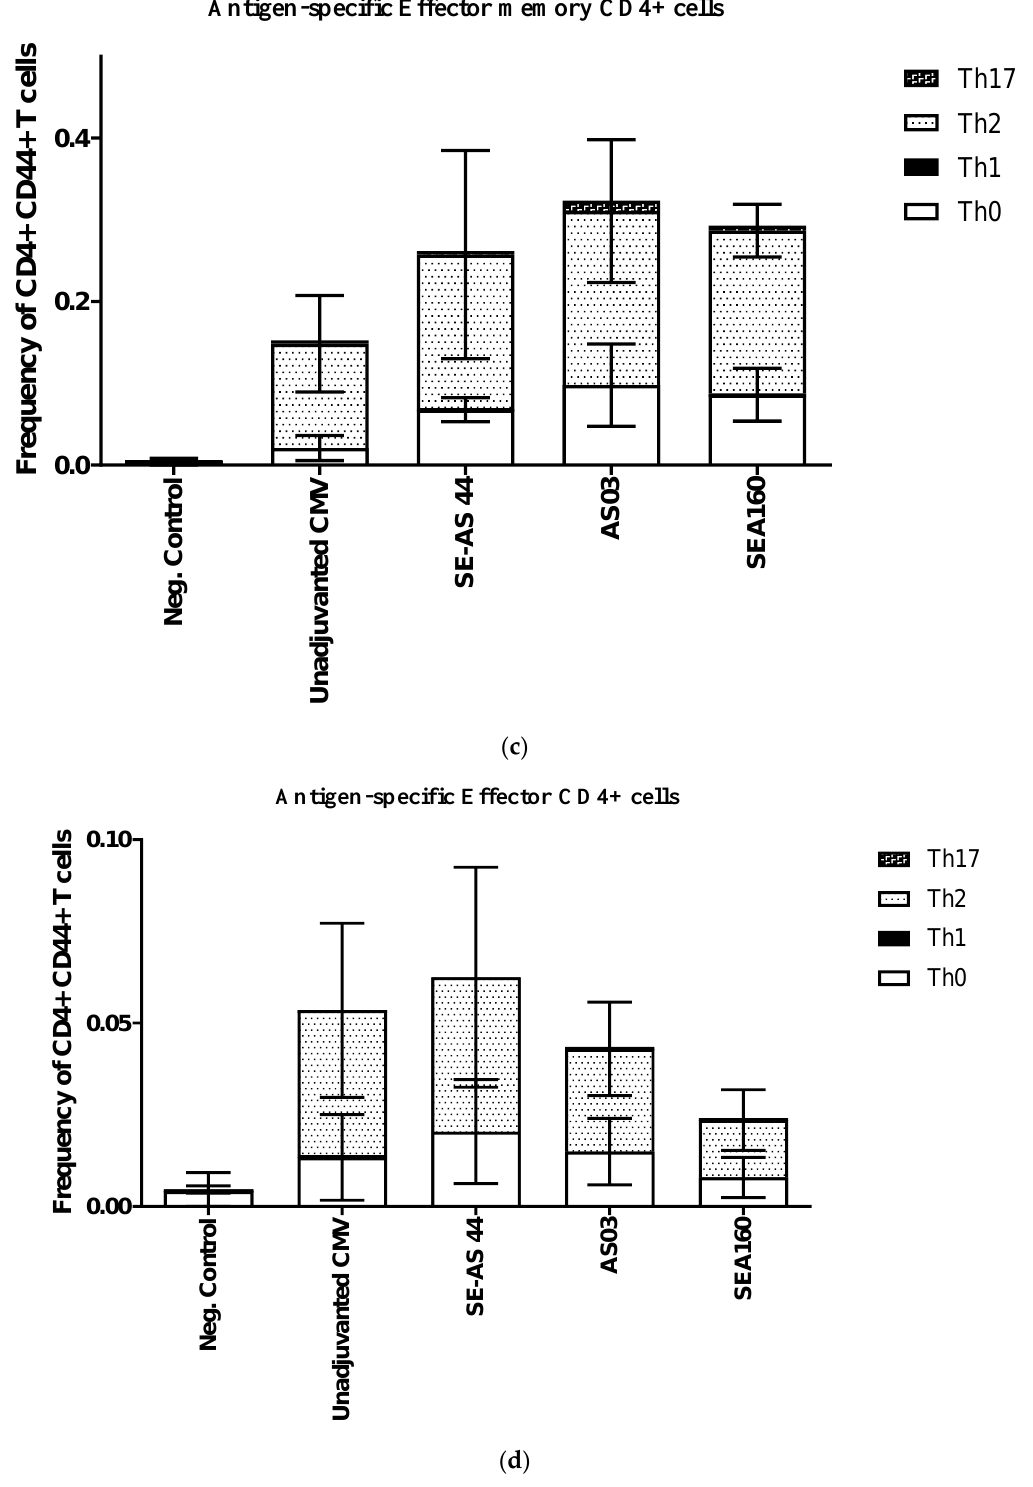
Figure 4. ( a ) Frequencies of overall antigen-specific CD4+ T cells classified as either central memory, effector memory or effector cells. Each bar represents stacked mean frequency data from n = 5 animals with standard deviation. Supplementary Table S2a shows frequency of cells for each group. ( b ) Frequencies of antigen-specific Th2-type CD4+ T cells classified as either central memory, effector memory or effector Th2 cells. Each bar represents stacked mean frequency data from n = 5 animals with standard deviation. Supplementary Table S2b shows frequency of cells for each group. ( c ) Frequencies of antigen-specific effector memory cells gated from Quadrant 3 after gating for